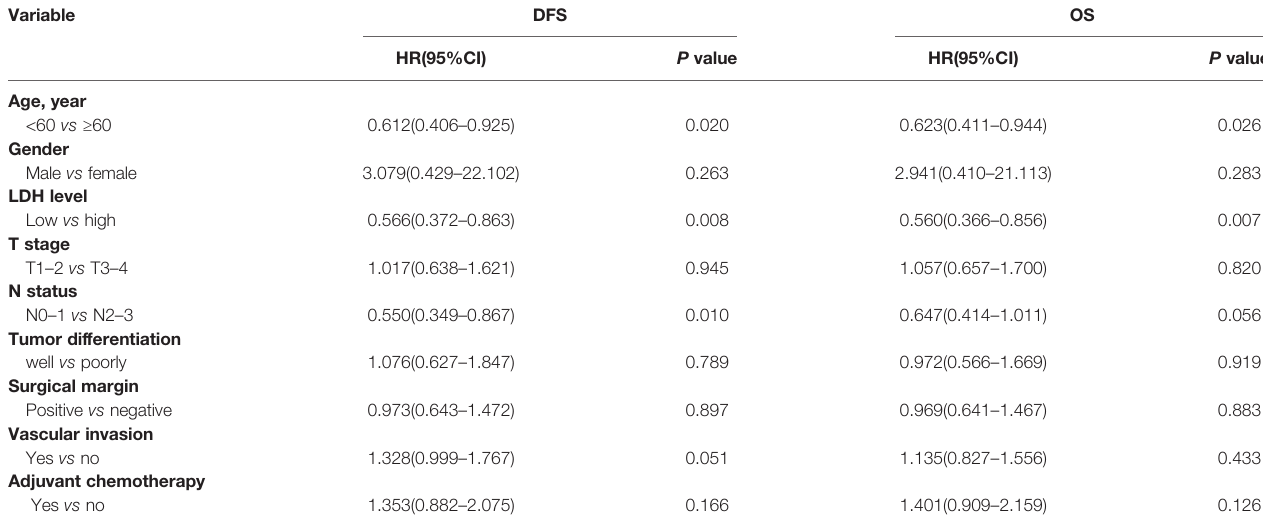
TABLE 4 | Univariate analysis of DFS and OS for the Whole Group.